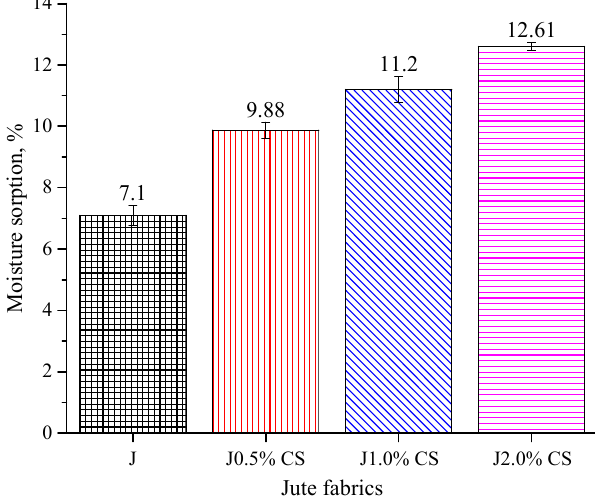
Figure 5. Moisture sorption of raw and chitosan-treated fabrics.